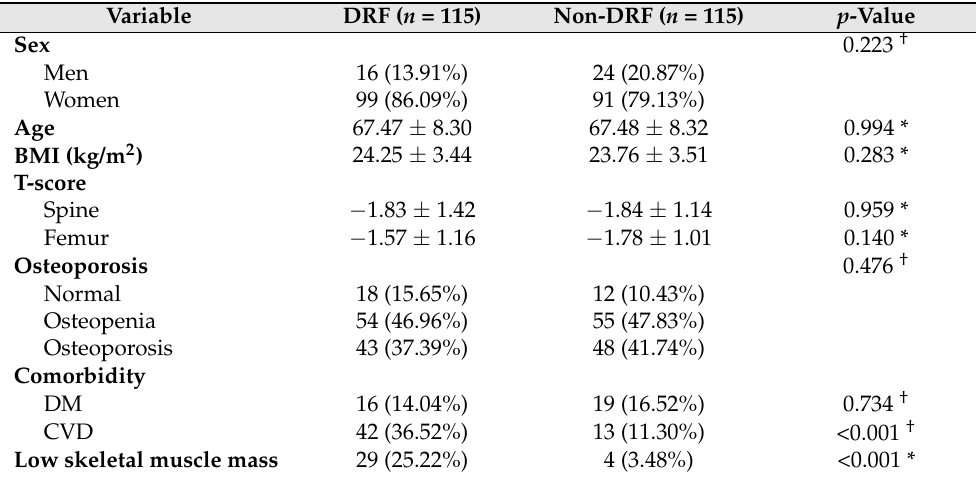
Table 2. Univariate analysis of factors associated with DRF after adjusting